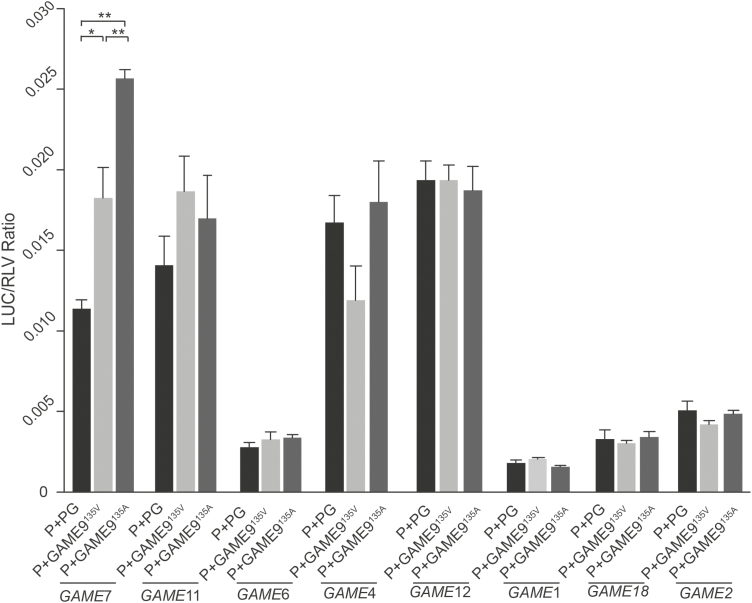
Transactivation assays of putative downstream gene promoters by GAME9135V and GAME9135A. The capacity of GAME9135V and GAME9135A to transactivate eight different promoters of candidate downstream genes was evaluated in tobacco leaves. P, promoter fragment of candidate downstream genes; PG, pGreen II 62-SK empty vector. A validation experiment (n>8) was performed. Asterisks indicate statistically significant differences determined using a t-test: *P<0.05, **P<0.01.